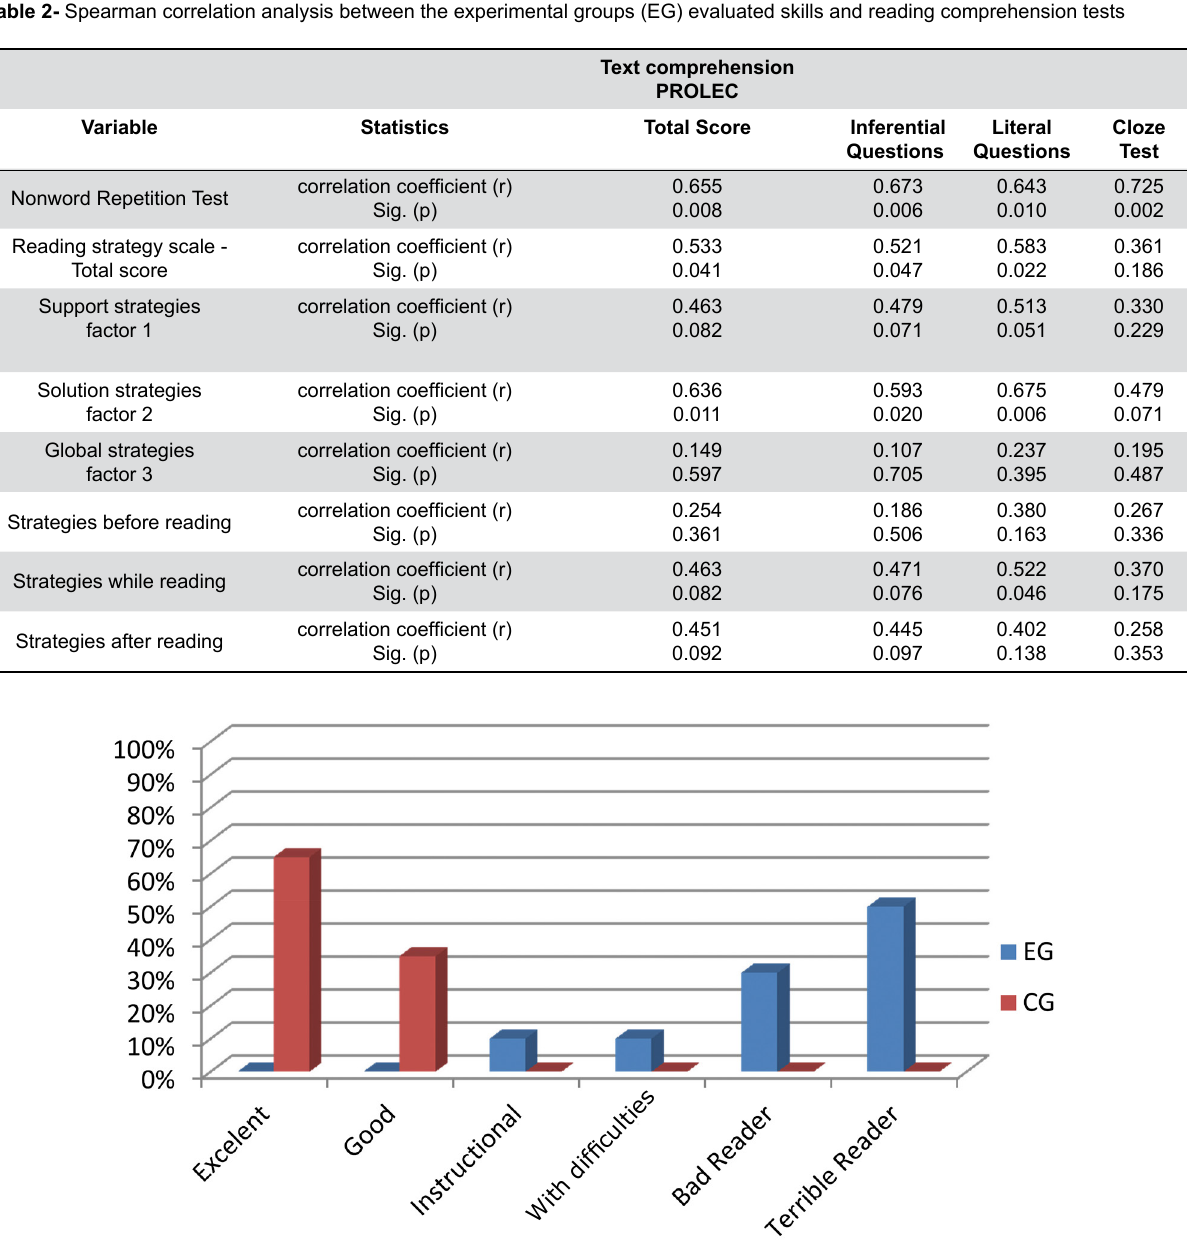
Figure 2- Percentage of ratings occurrence of Cloze Test in the experimental and control